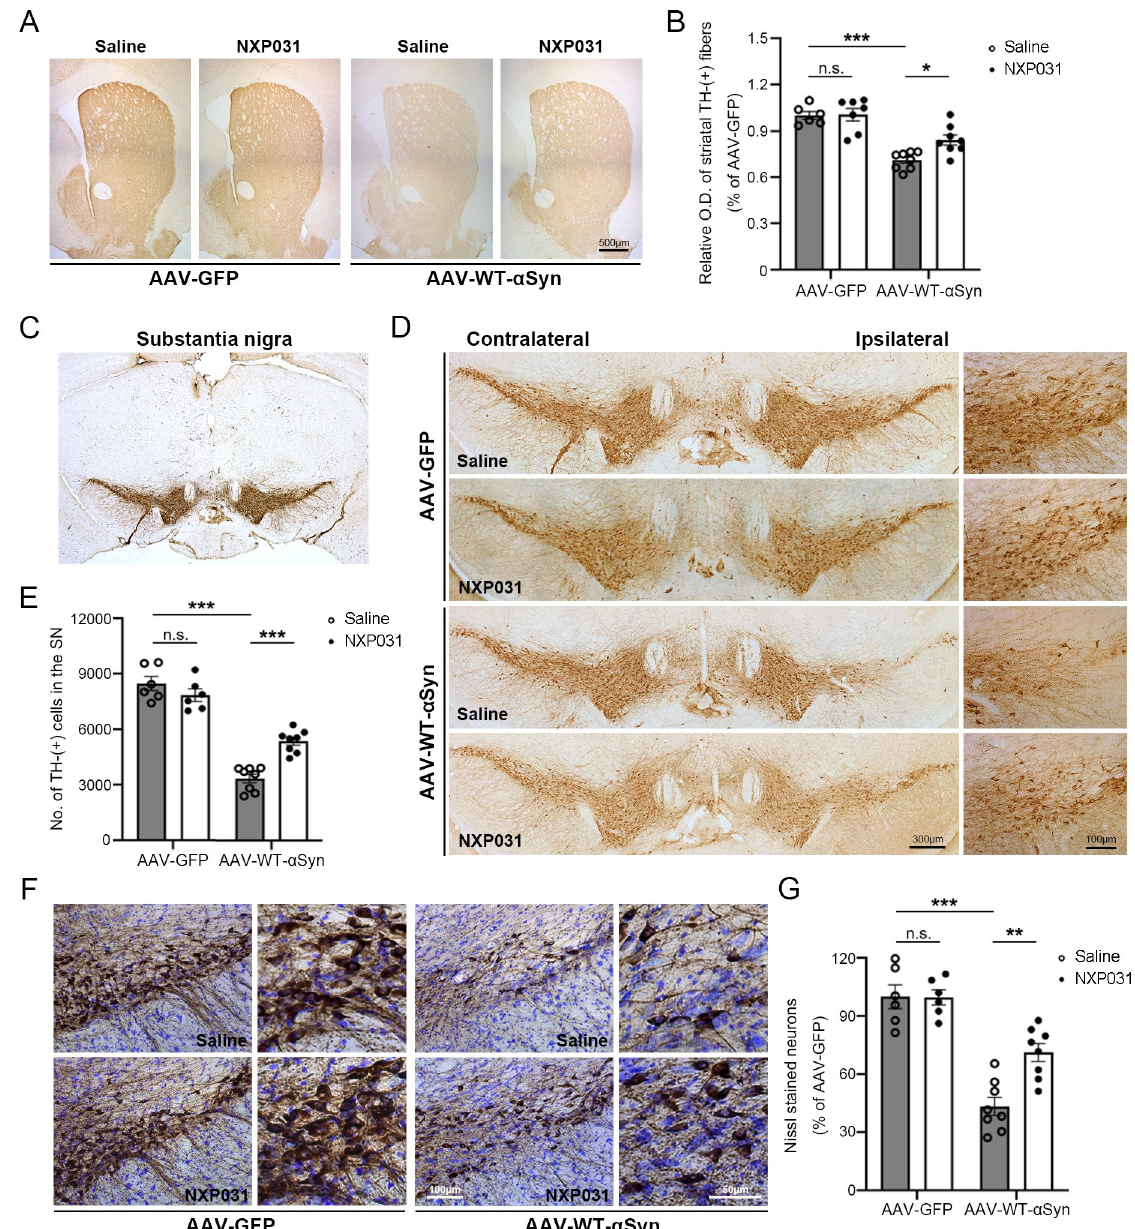
Fig 2. Effect of NXP031 on TH-immunoreactivity in the striatum and SN at 9 weeks after delivery of GFP-only or α -Syn AAV. (A) Representative micrographs of TH immunostaining in the striatum. (B) The relative optical density of TH-stained dopaminergic fiber in the striatum (C, D) Representative micrographs of TH immunostaining in the SN. (E) The number of TH-positive neurons in the SN. (F) Representative micrographs of double staining with TH antibody and Nissl violet in the SN. (G) % of Nissl-positive neurons compared to the AAV-GFP group. Data are presented as the mean ± S.E.M. (Two-way ANOVA followed by Tukey’s test, � p < 0.05, �� p < 0.01, ��� p < 0.001 compared to selected group, n = 6–8 mice per group).